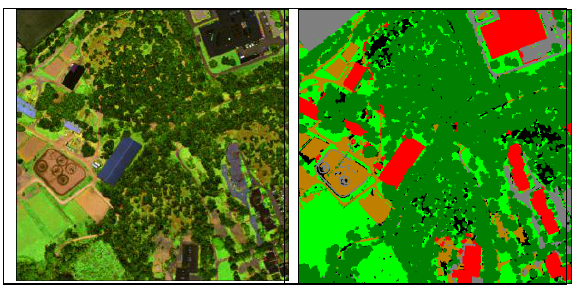
Figure 3. Optech Titan colour coded image (left) and classified image (right).